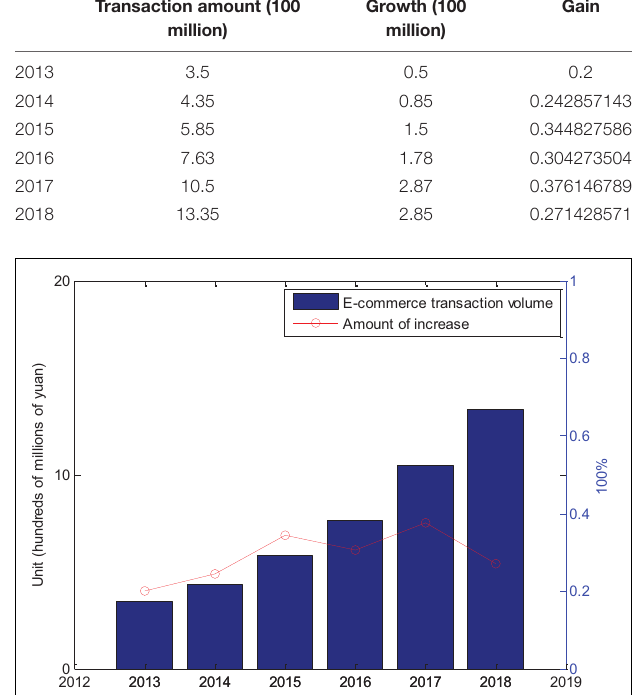
TABLE 1 | Scope of China’s e-commerce transactions.